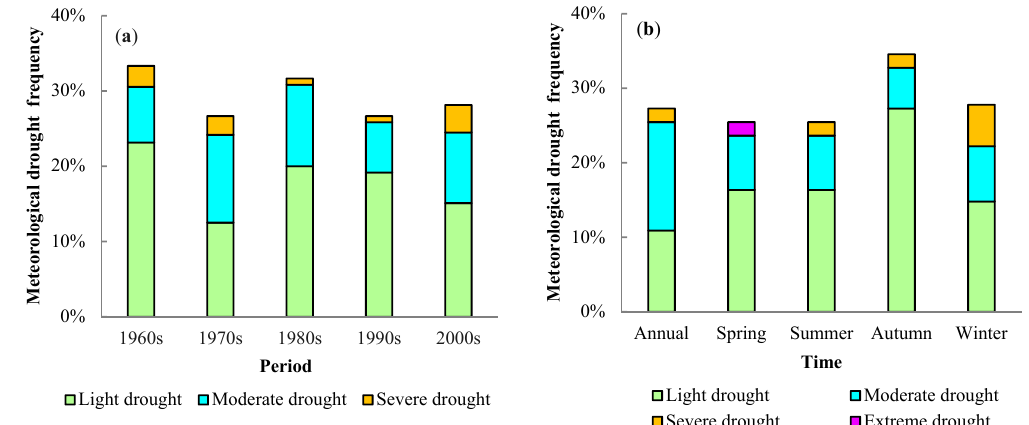
Figure 9. Cumulative frequencies of the meteorological drought in the Poyang Lake Basin over the period of 1961–2015. ( a ) Based on the Decadal SPEI; ( b ) Based on the annual and seasonal SPEI.